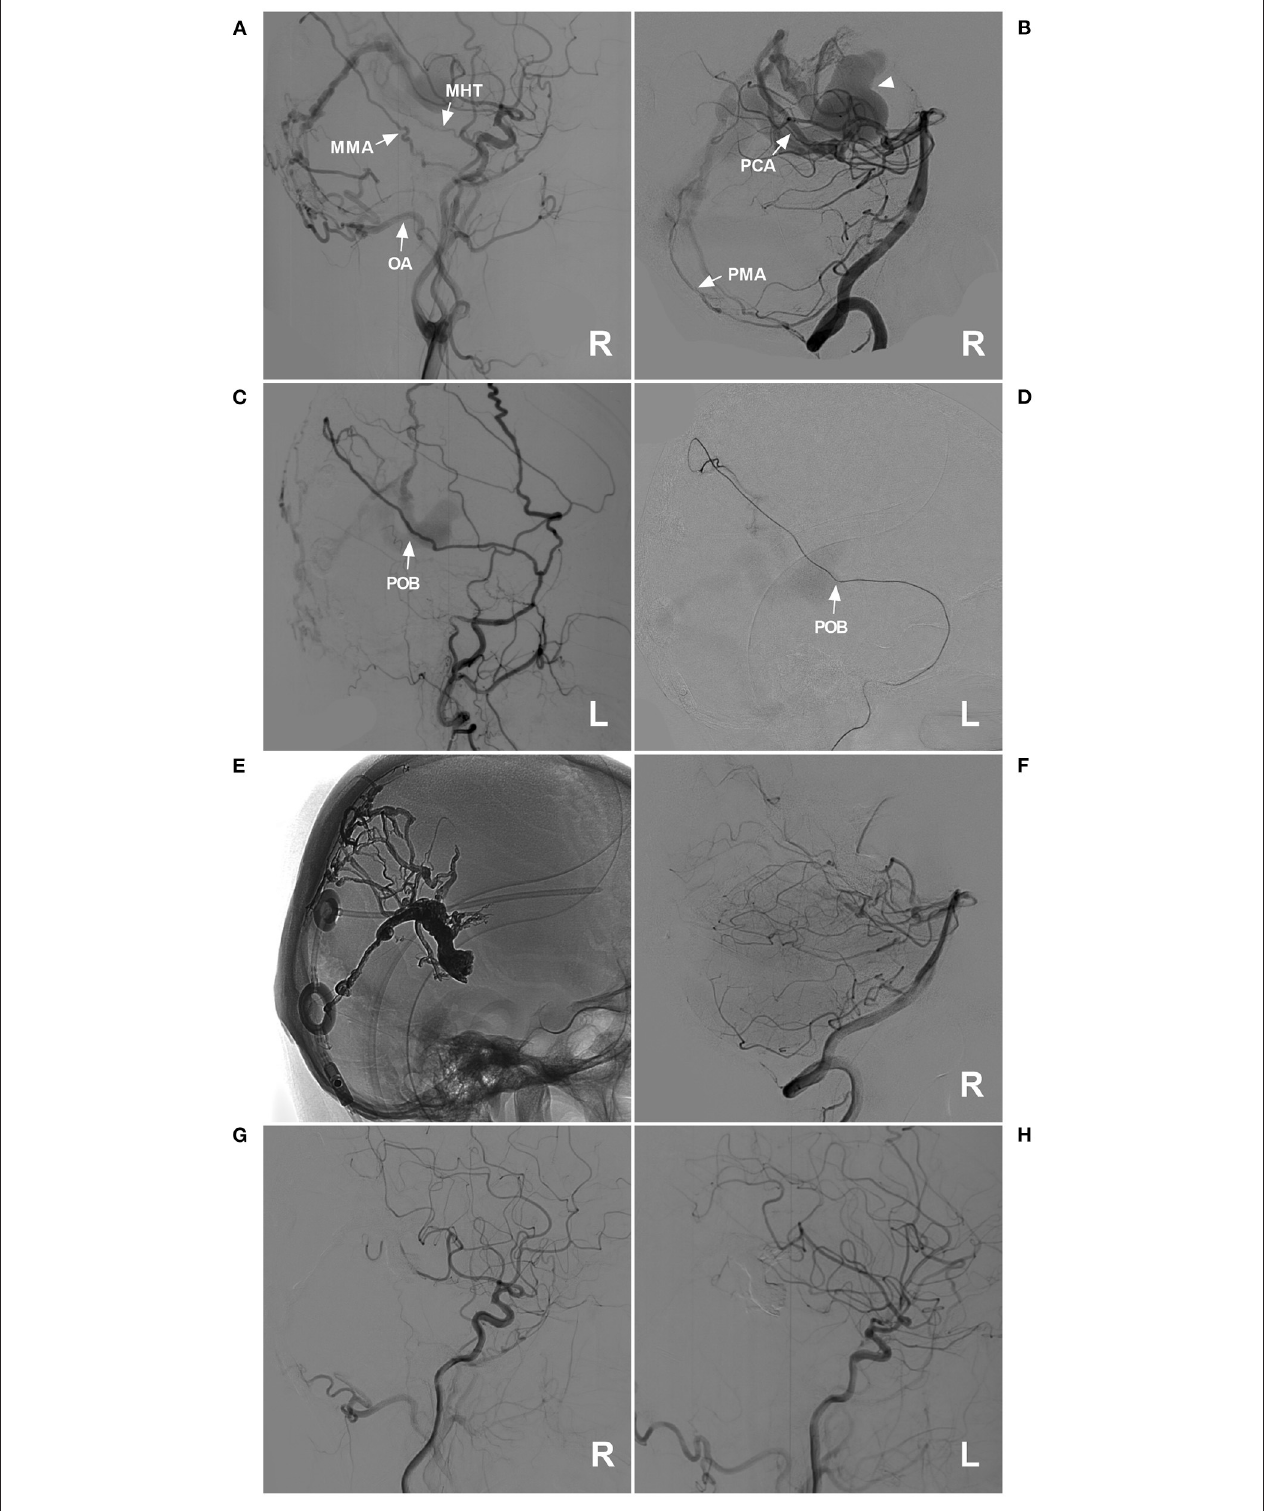
FIGURE 6 | Successful type IIa EVT for a DAVF of the posterior falx cerebri. (A) Lateral view DSA of the right carotid artery showed a DAVF at the posterior falx cerebri that was supplied by the MHT, the POB of the MMA, and the OA (arrows). (B) DSA of the right VA showed that the dural branch of the PCA (arrow) and the PMA